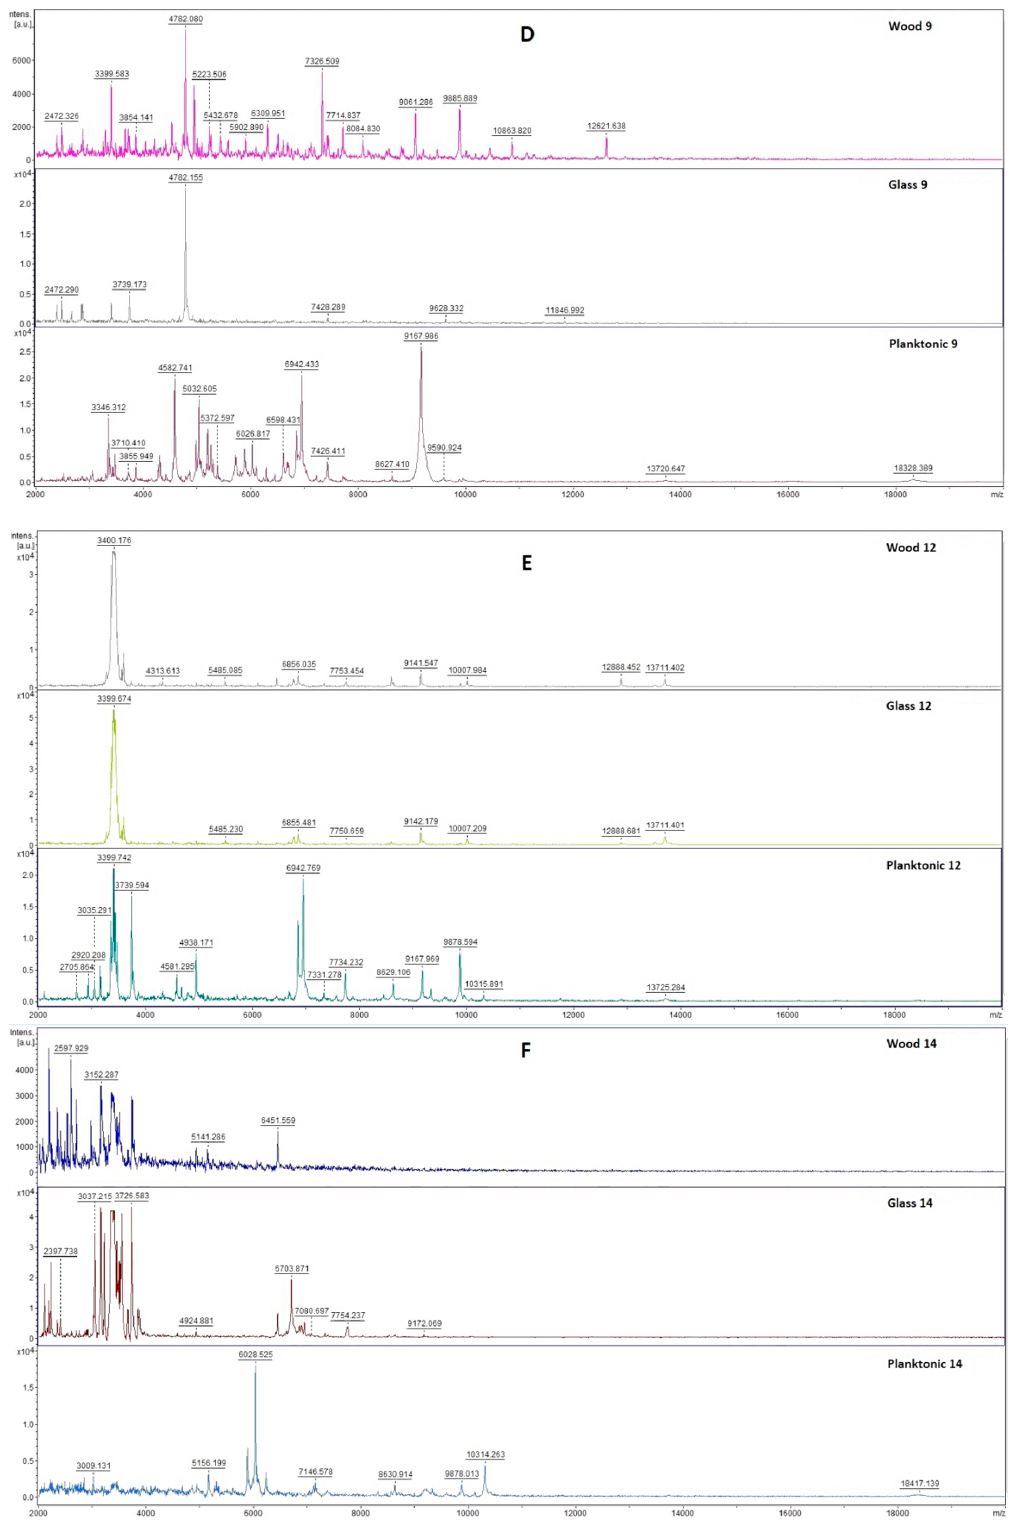
Figure 3. Representative MALDI-TOF mass spectra of B. subtilis : ( A ) 3rd day, ( B ) 5th day, ( C ) 7th day, ( D ) 9th day, ( E ) 12th day, and; ( F ) 14th